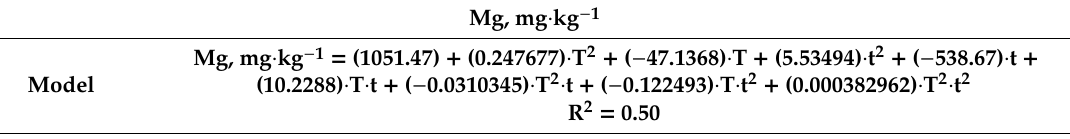
Table A15. The statistical parameters of polynomial regression analysis of the influence of SS torrefaction temperature and residence time on the Mg content in